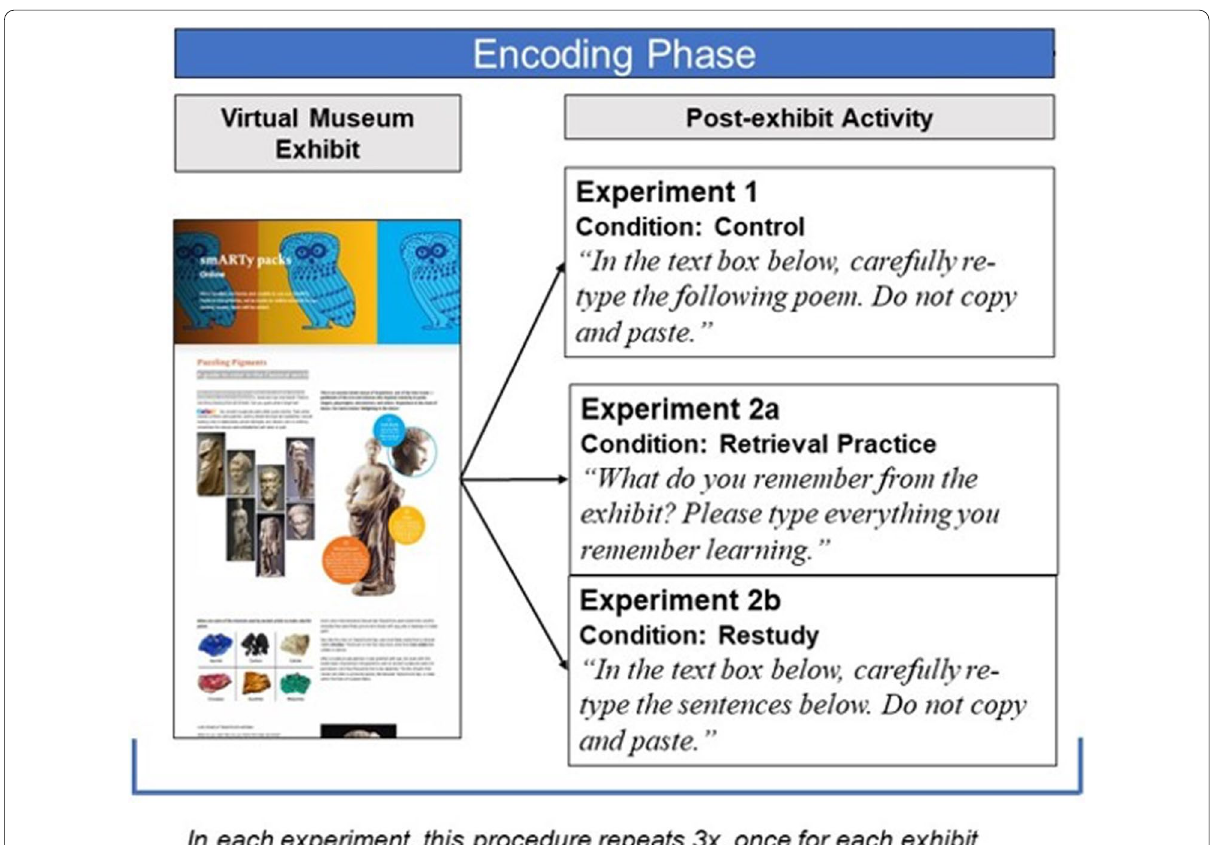
Fig. 1 Schematic illustrating general encoding phase procedure for all three experiments . Note Experiments 2a and 2b are yoked such that the exact content generated by Experiment 2a participants during retrieval practice is presented to participants in Experiment 2b for